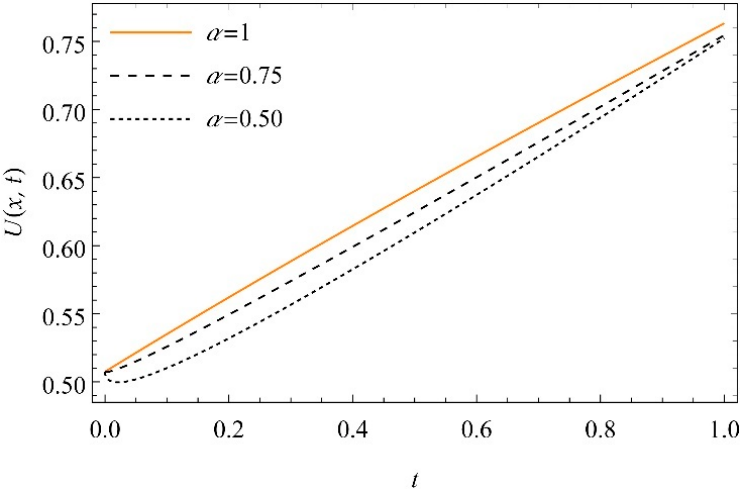
Figure 6. The graph of U ( x , t ) versus time t at n = 1, x = 0.5, and for α = 1, 0.75, 0.50 for Equa-